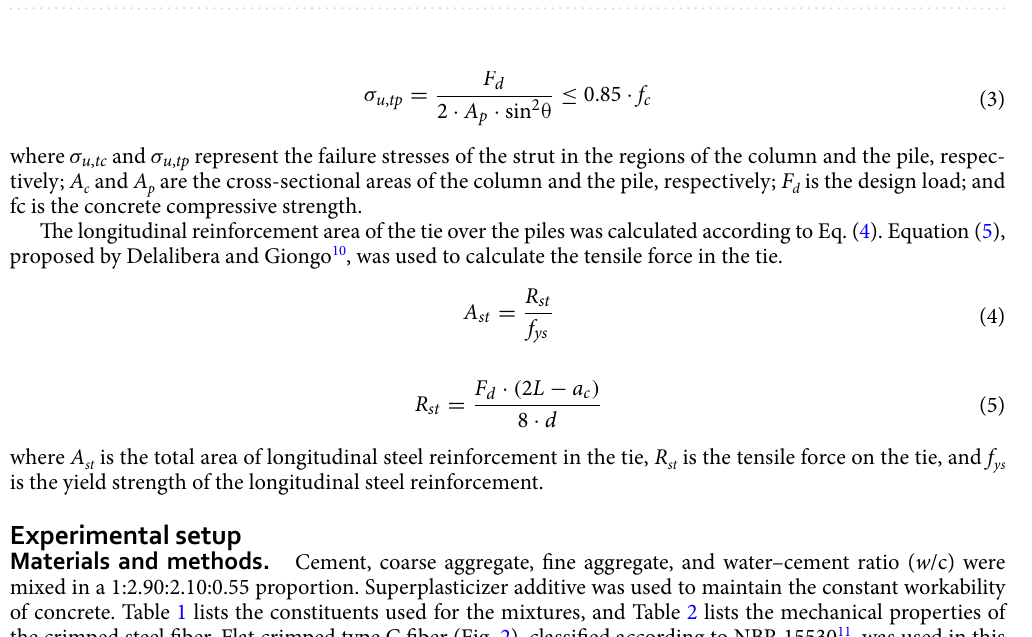
Figure 1. Strut-and-tie model for a two-pile cap (Note: F d /2 is the column load for a pile; R cb is the compressive force on the strut; R st is the tensile force on the tie; θ is the angle of inclination of the